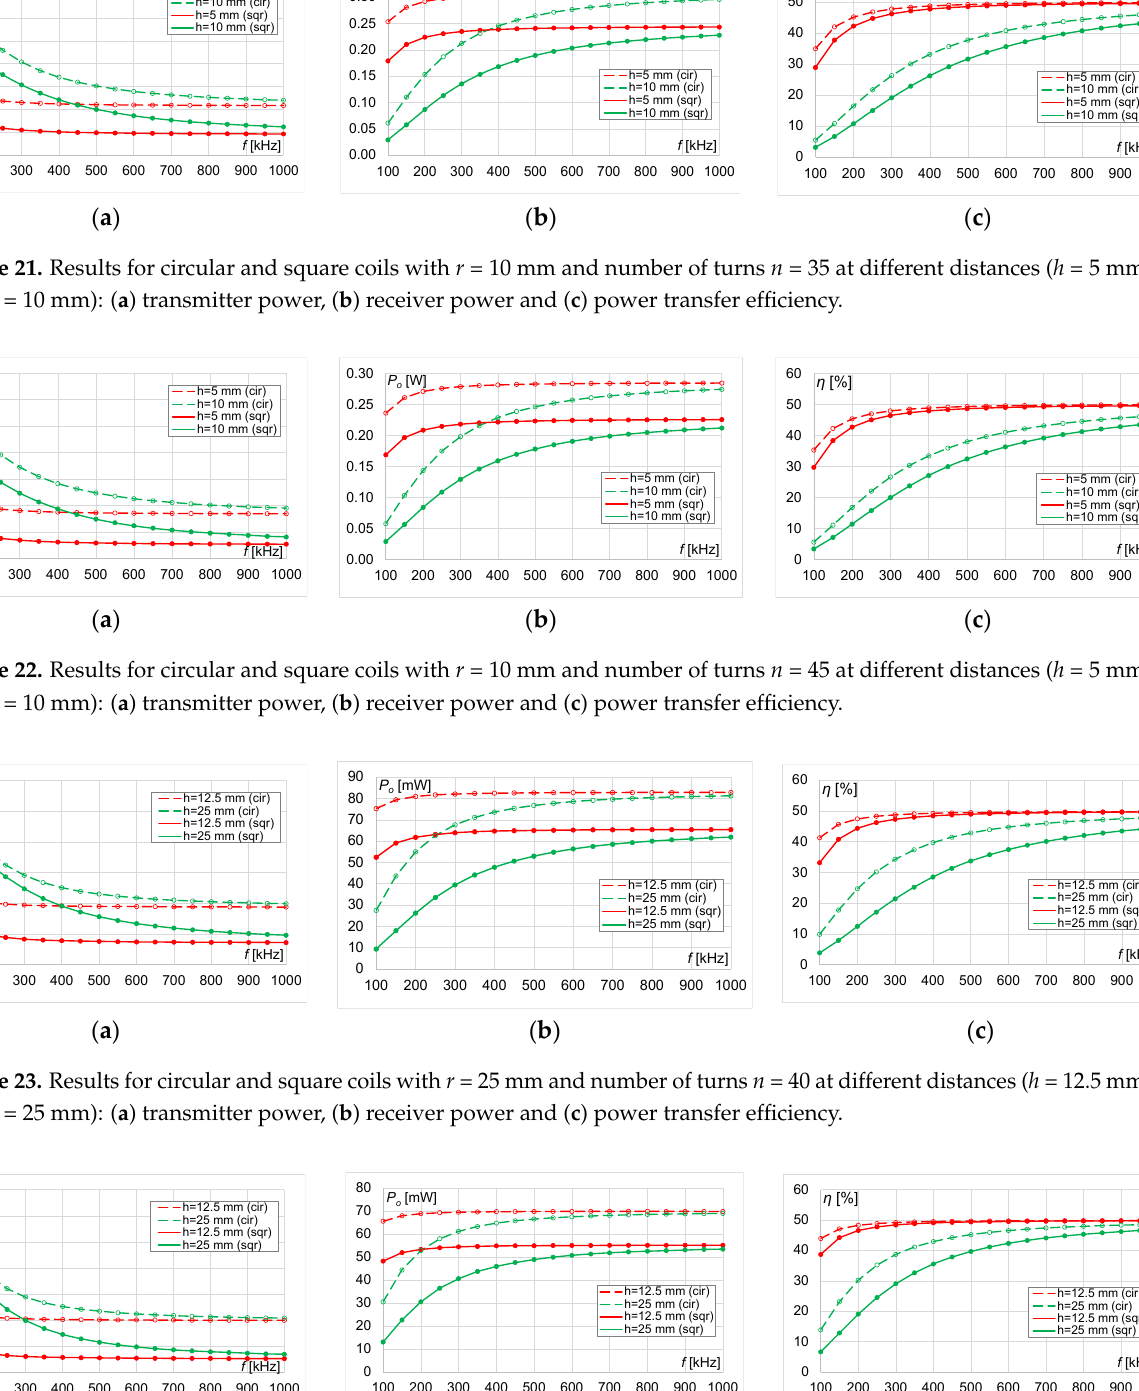
Figure 24. Results for circular and square coils with r = 25 mm and number of turns n = 50 at different distances ( h = 12.5 mm and h = 25 mm): ( a ) transmitter power, ( b ) receiver power and ( c ) power transfer efficiency.